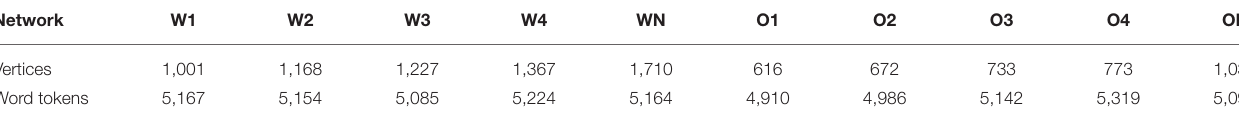
TABLE 3 | Basic information for each network. Network W1